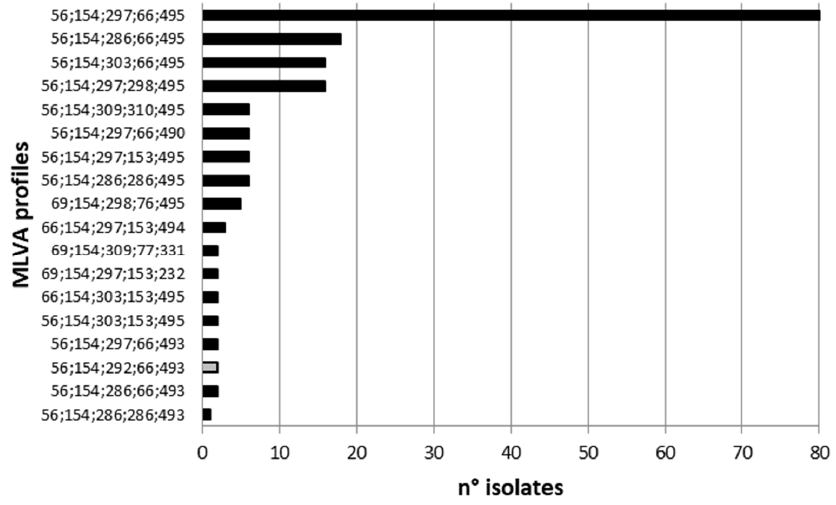
Figure 3. Occurrence (n.) of MLVA profiles observed in S. Infantis strains isolated from 2018 to 2020. All isolates were amplified using the loci selected in this study. The locus STTR9 was detected as a single allele, while the locus SG2 showed six different alleles, STTR3 showed five alleles, STTR5 showed four alleles, and Sty19 showed three alleles. (Table